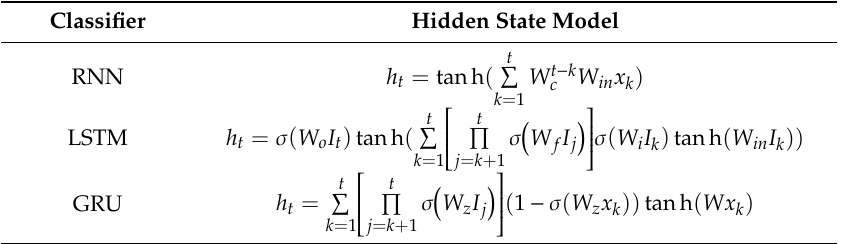
Table 1. The Hidden State in Sequence Modeling Classifier.